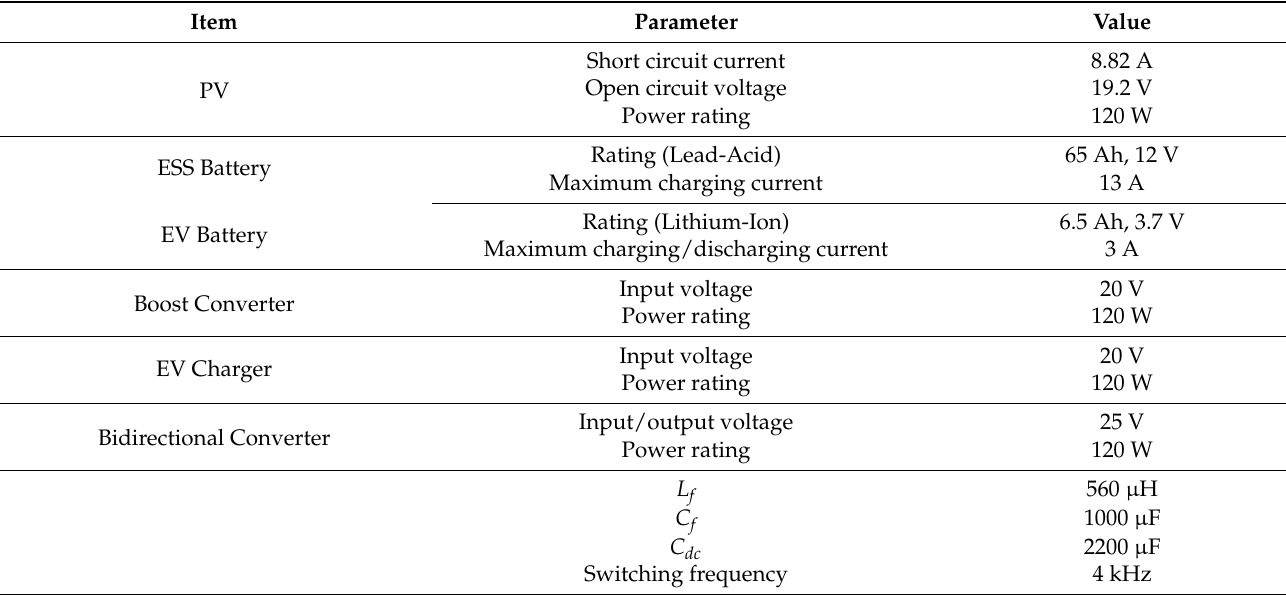
Table 2. The parameters and specifications of the